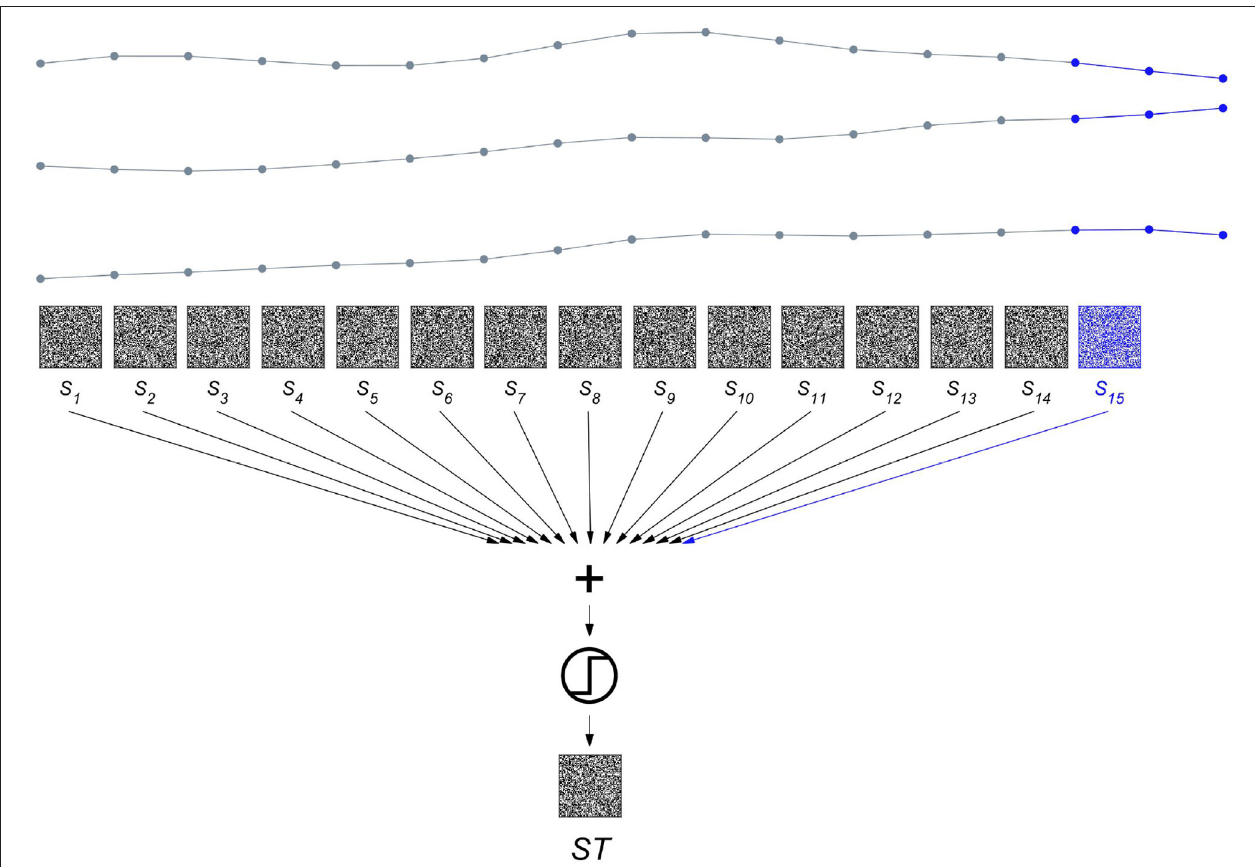
FIGURE 5 | Bundling spatial representations over time produces a spatiotemporal composite representation. The three intracranial electroencephalogram (iEEG) signals are the same as shown in Figure 3 , but stretched horizontally to enable the display of all the composite spatial representations S t ∈ 1 : 15 . S 15 plotted in blue is identical to S of Figure 3 . Each of the HD vectors S t is aligned with the first of the three sampling points that are compared to yield the order relation patterns. Bundling the 15 composite representation S t ∈ 1 : 15 produces the spatiotemporal composite representation ST